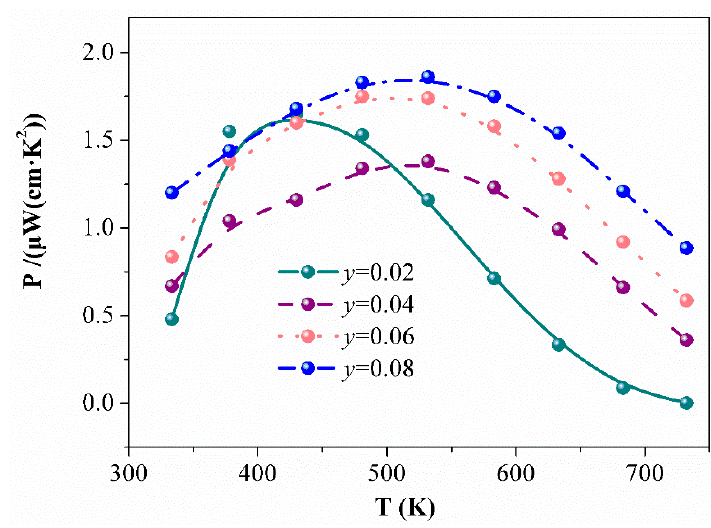
Figure 5. The power factor of Eu 5 − y La y In 2.2 Sb 6 ( y = 0.02, 0.04, 0.06, 0.08) depending on the temperature. The thermal diffusion coefficient ( D ), total thermal conductivity ( κ total ), electronic thermal conductivity ( κ e ), lattice, and bipolar thermal conductivity ( κ L + κ B ) of La-doped samples are presented in Figure 6. All thermal diffusion coefficients are relatively low, ranging from 0.57–0.93 mm 2 /s, which is comparable to p -type Eu 5 In 2 Sb 6 (Figure 6a) [18]. Therefore, the calculated total thermal conductivity is between 0.7 W/mK and 1.15 W/mK (Figure 6b). With increasing La contents, the total thermal conductivity decreases as result of the lattice disorder.